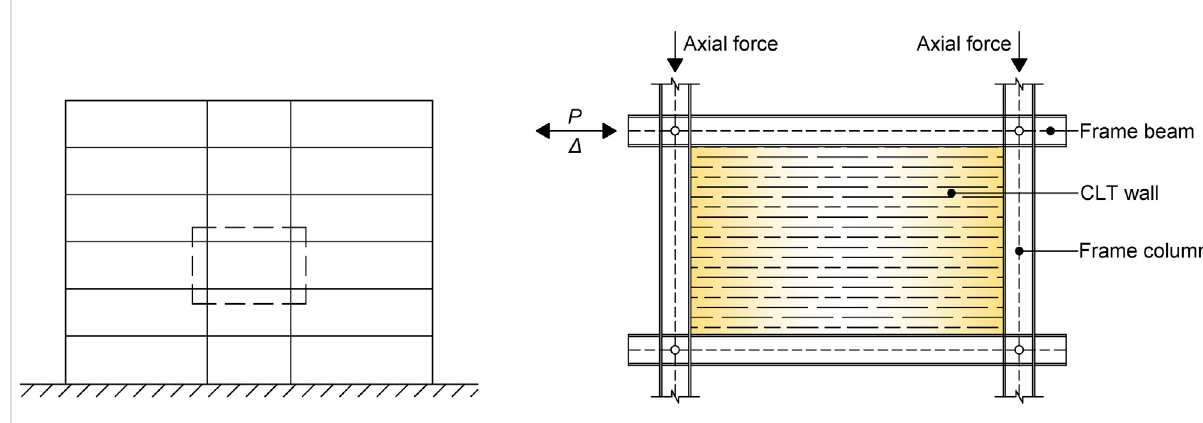
FIGURE 1 Typical elements of a steel frame with CLT shear wall hybrid system, STSW.